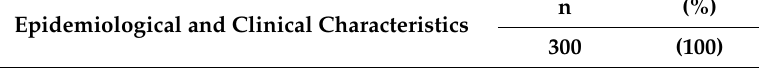
Table 2. Clinical and epidemiological characteristics of 300 women with breast cancer and 27 familial breast cancer risk